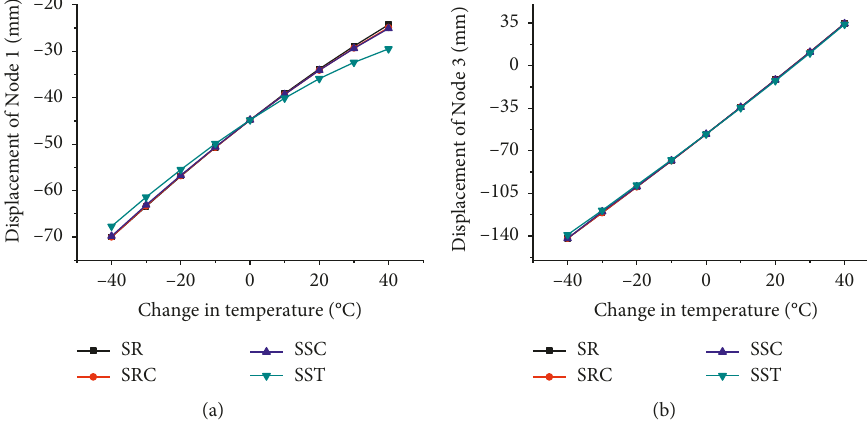
Figure 3: Relationship between the displacement and temperature in the full-span load distribution. Displacement of (a) Node 1 and (b) Node 3 with varying temperature.